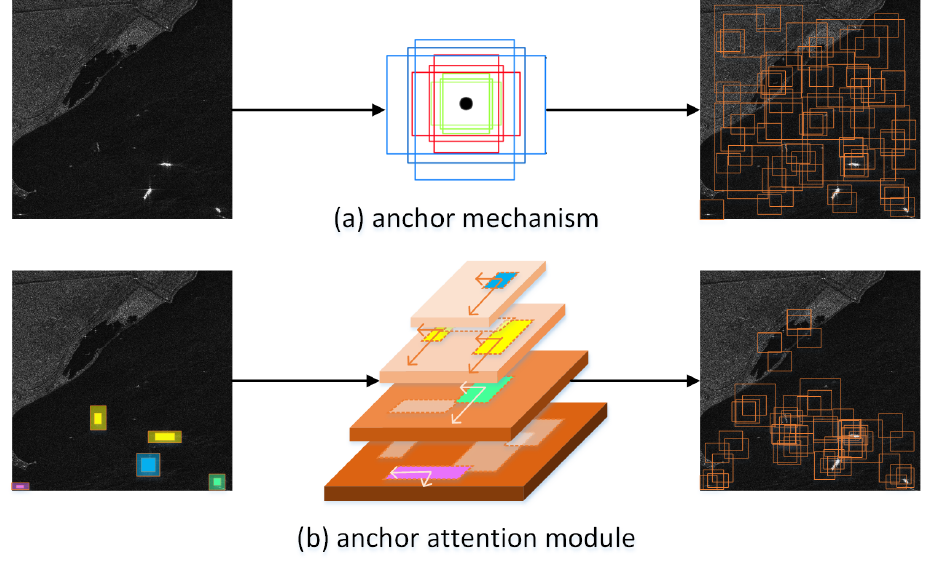
Figure 4. The difference between using artificial anchor settings and feature-based anchor generation with